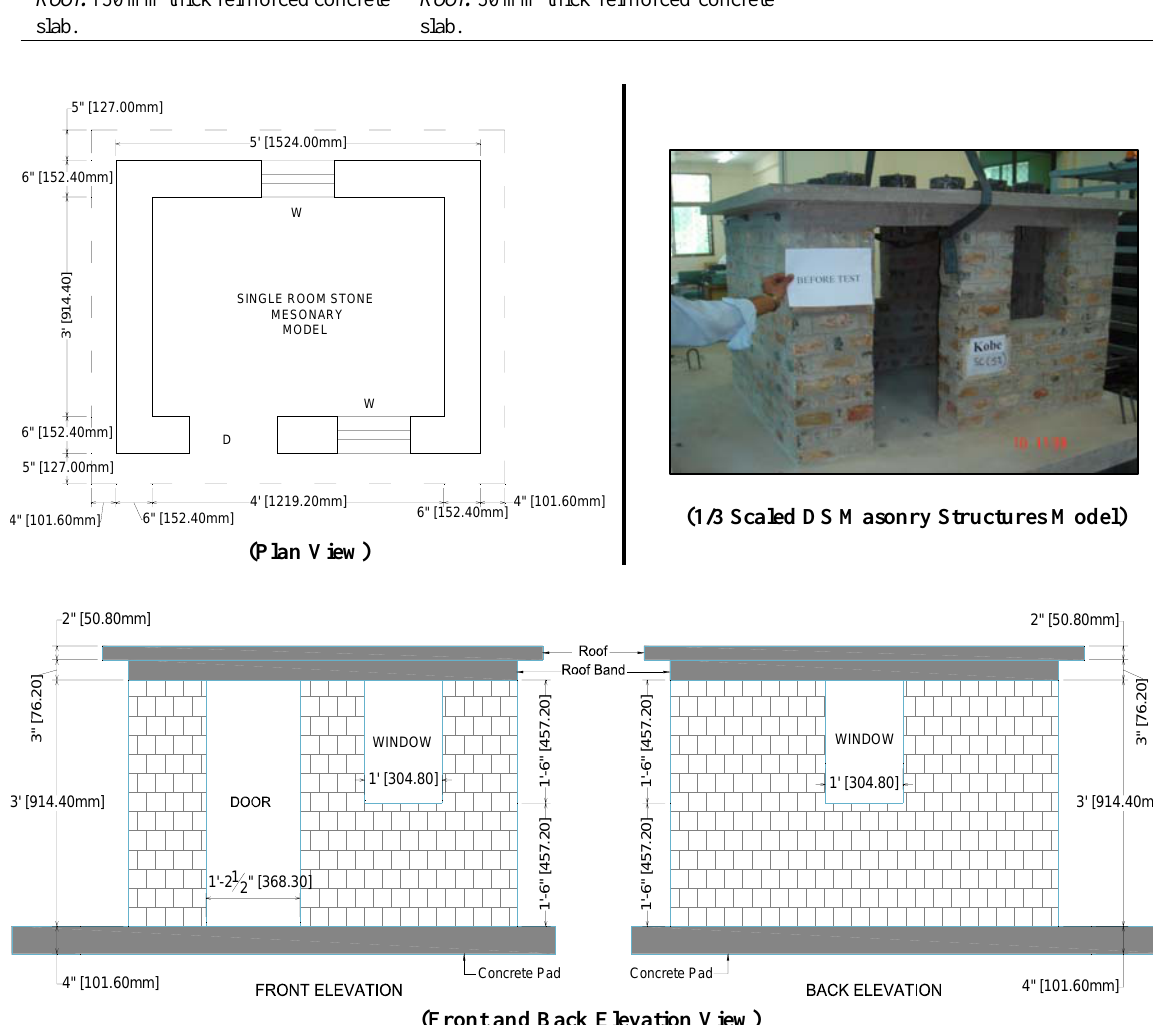
Fig. 3. Geometric details of the structural model tested at the Earthquake Engineering Center of UET